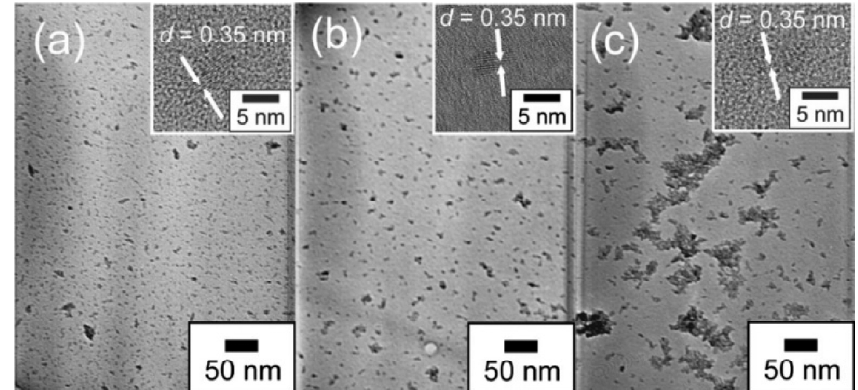
Fig. 3. FESEM micrographs of NTPs synthesis in hydrothermal process, heating at 80 °C for (a) 30 h, (2) 42 h, (3) 70 h, reprinted with permission from N. Watanabe, T. Kaneko, Y. Uchimaru, S. Yanagida, A. Yasumori and Y. Sugahara // CrystEngComm. 15 (2013) 10533, (c) 2013 Royal Society of